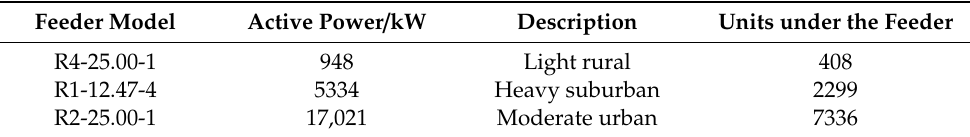
Table 2. House units under di ff erent feeder models [70,71].